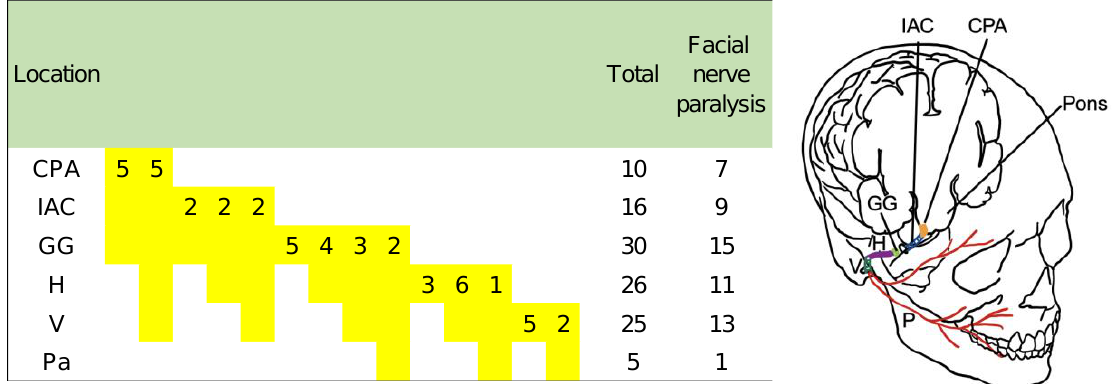
Figure 1. Tumor location and facial nerve function. CPA: cerebellopontine angle, IAC: internal auditory canal, GG: geniculate ganglion, H: horizontal portion of the facial nerve, V: vertical portion of the facial nerve, PA: parotid gland.